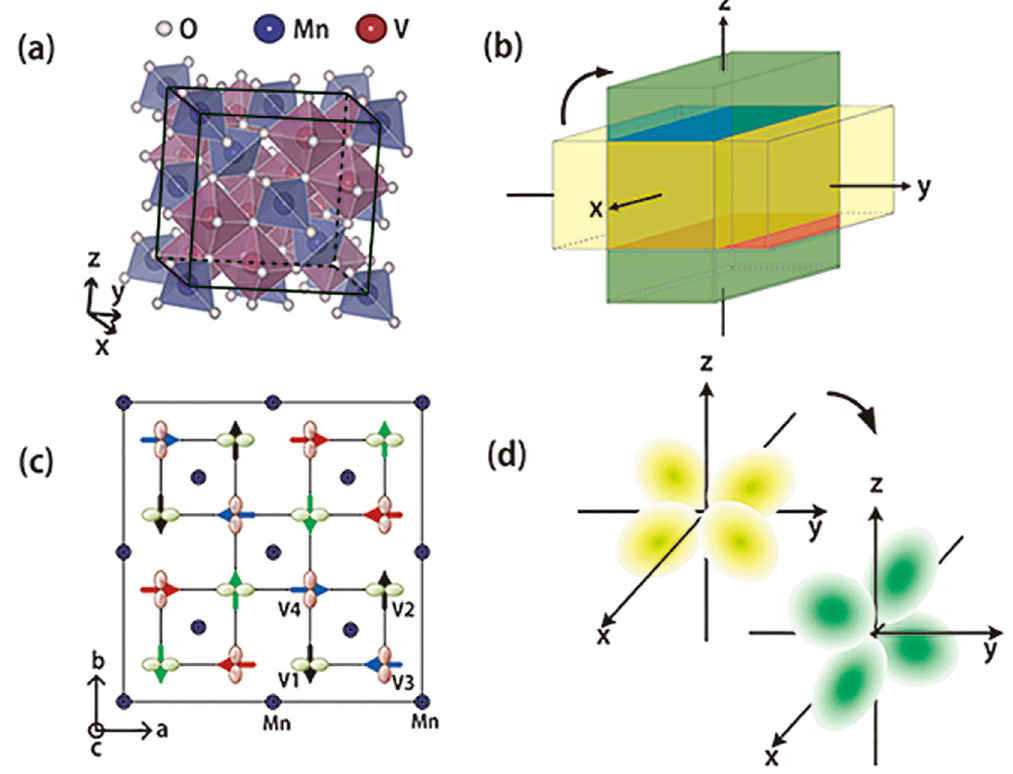
Figure 1. ( a ) Spinel oxide MnV 2 O 4 . The small white circles denote O 2 − ions. Large blue circles in the tetrahedral (A) sites surrounded by four oxygen ions are Mn 2 + ions. Large red circles in the octahedral (B) sites surrounded by six oxygen ions are V 3 + ions. ( b ) Magnetostriction: the short axis of the tetragonal unit cell is aligned along the external field direction. The short axis flips following the net magnetic moment that rotates from the z -axis to the y -axis with the external field. ( c ) The spin and orbital states of MnV 2 O 4 viewed along the [001] direction. The arrows represent four different directions of the V 3 + magnetic moments, which are approximately 65° away from the axis opposite to the Mn moment aligned along the c-axis. Identically colored arrows are in the same basal plane. The blue circles represent manganese ions. ( d ) With the macroscopic easy axis flipping, the orbital state also changes the symmetry